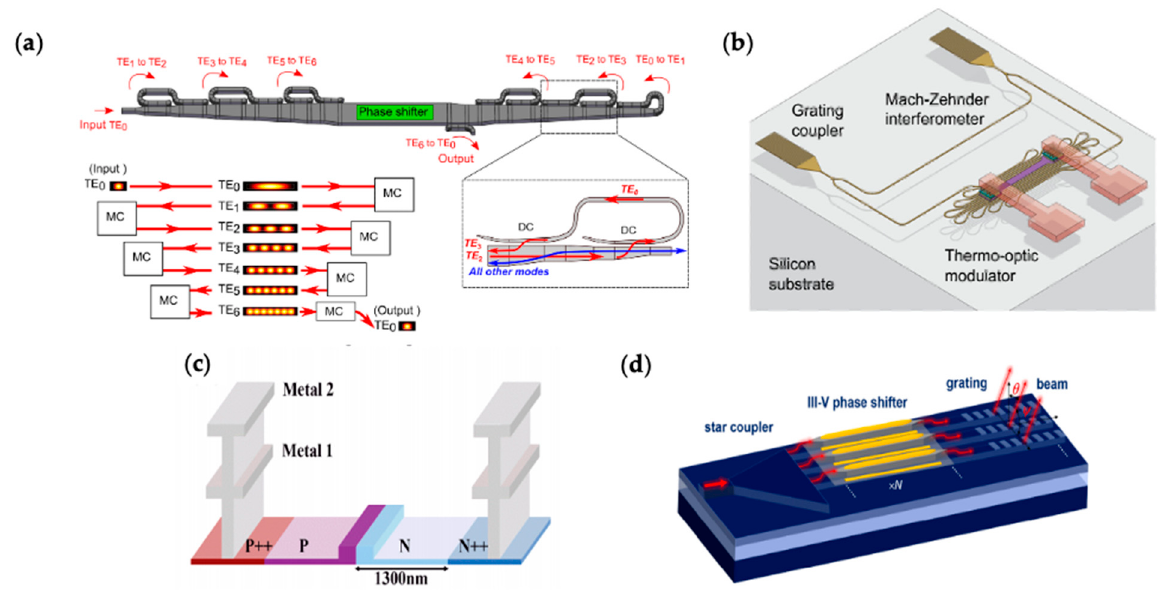
Figure 3. Various phase shifters employed in OPAs. ( a ) Multi-pass thermo-optic shifter [12]. ( b ) Thermo-optic phase shifter with dense dissimilar waveguide routing [36]. Reprinted with permission from [12,36] © The Optical Society. ( c ) Phase shifter based on the plasma dispersion effect. © 2022 IEEE. Reprinted with permission, from [38]. ( d ) Heterogeneous III-V/silicon phase shifter. Reprinted with permission from [39] © The Optical Society.